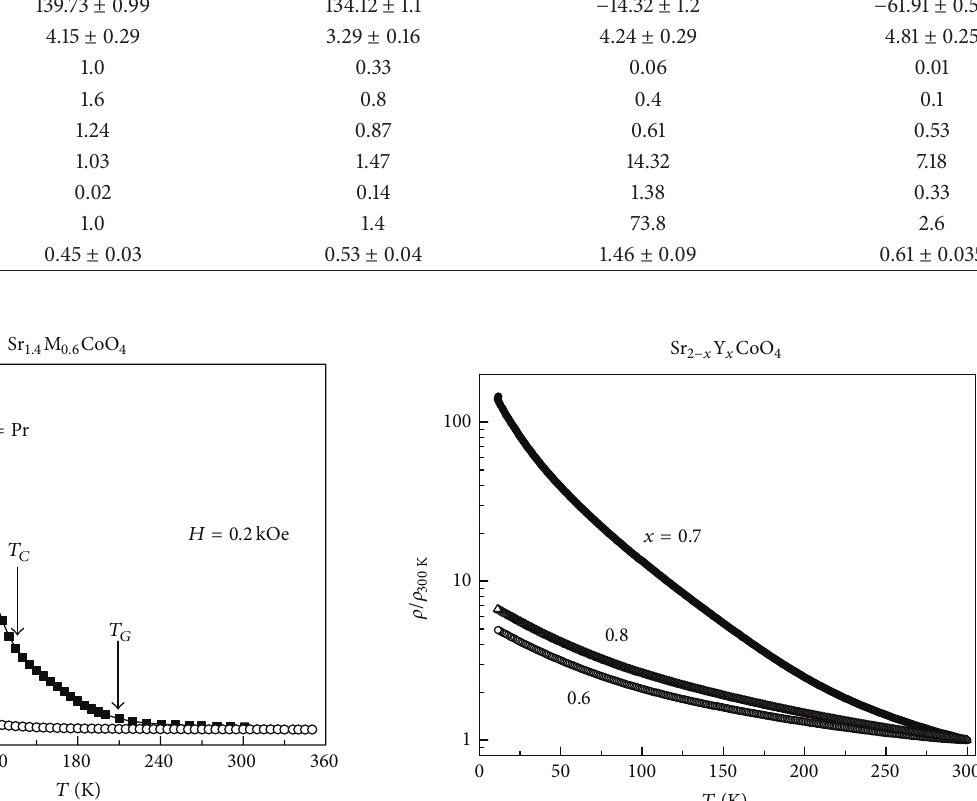
) as a function of 𝑇 K